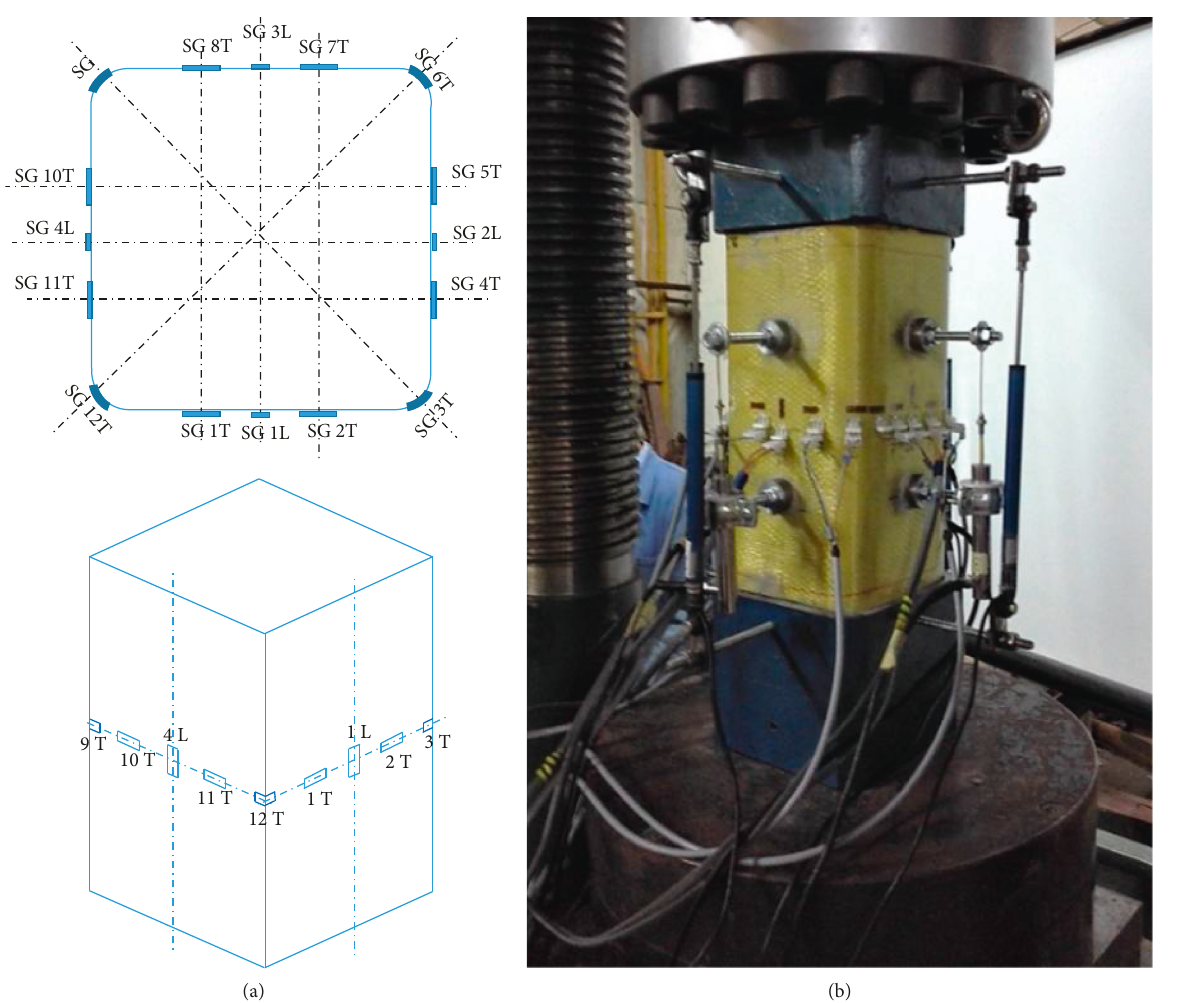
Figure 3: Arrangement of LVDT and strain gauges on the AFRP jacket. (a) Position of strain gauges. (b) Fully instrumented specimen.